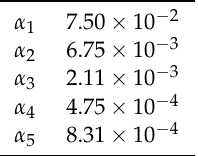
Figure 8. Input–output graph of the static nonlinearity (power series development with coefficients α n given in Table 1). Table 1. Coefficients α n of the estimated parametric Hammerstein